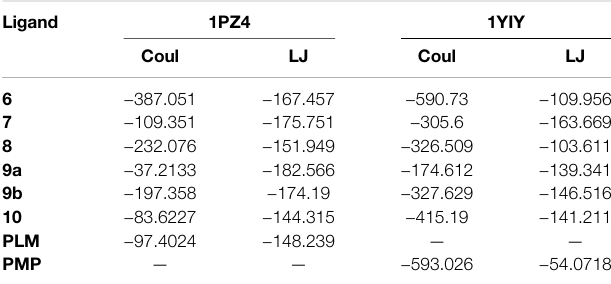
TABLE 5 | Coulombic and Lennard-Jones interaction energy